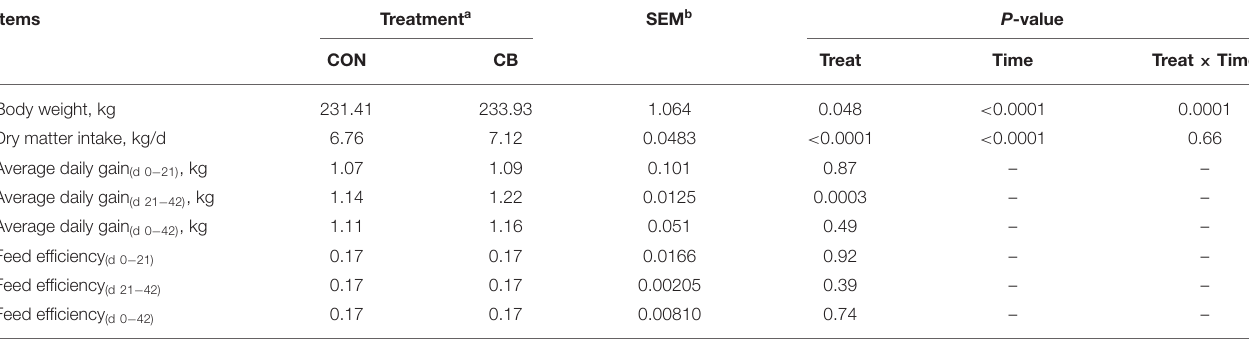
TABLE 3 | Effect of Clostridium butyricum on growth performance, feed efficiency, and average daily gain in heifers.